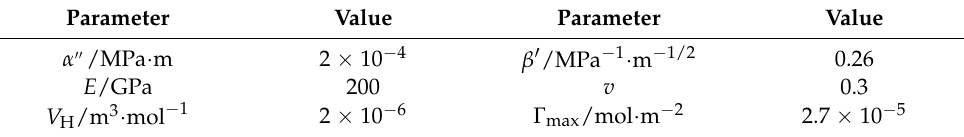
Table 2. Values for parameters [1,2,18–21,27,50] used in the fittings of experimental data by Equation (9). Parameter Value Parameter